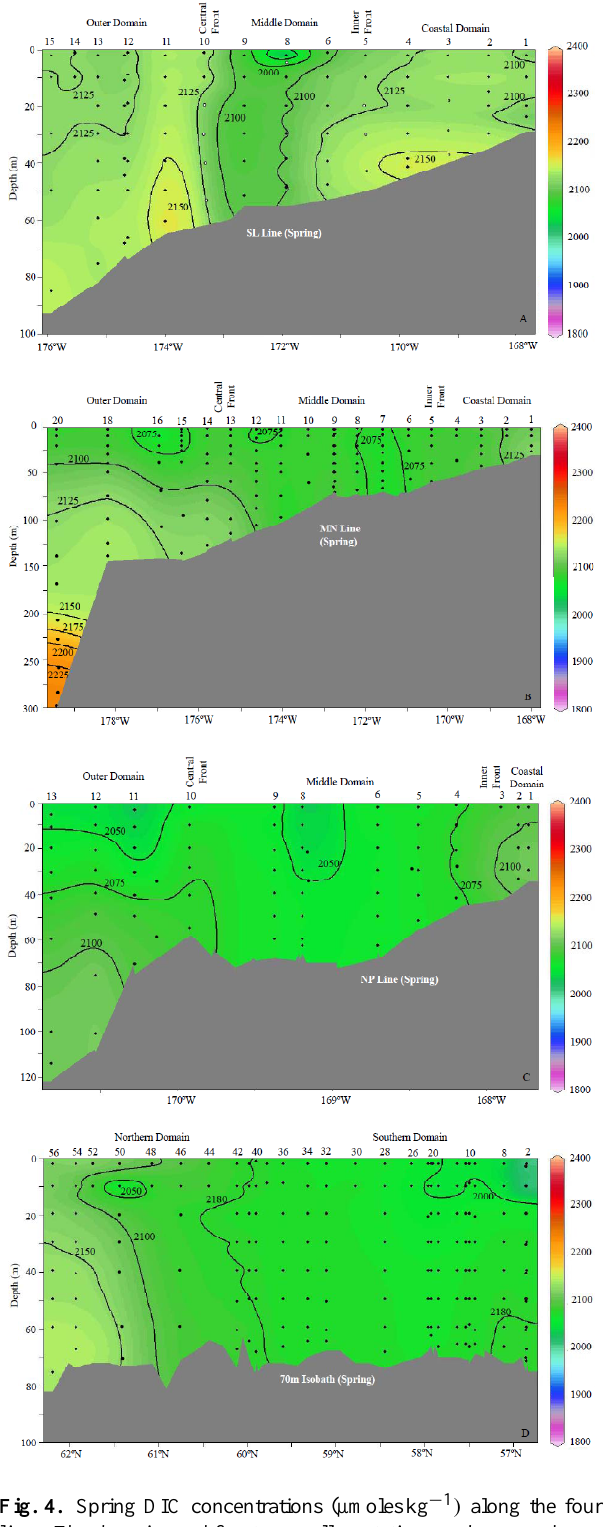
Fig. 4. Spring DIC concentrations (µmoleskg − 1 ) along the four lines. The domains and fronts as well as station numbers are shown across the top of each figure. A) SL line. B) MN Line. C) NP Line. D) 70m Line.